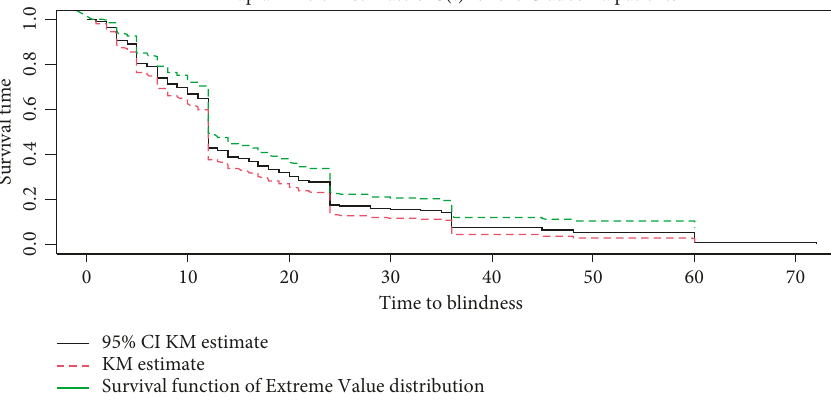
Figure 1: KM plot of glaucoma patients’